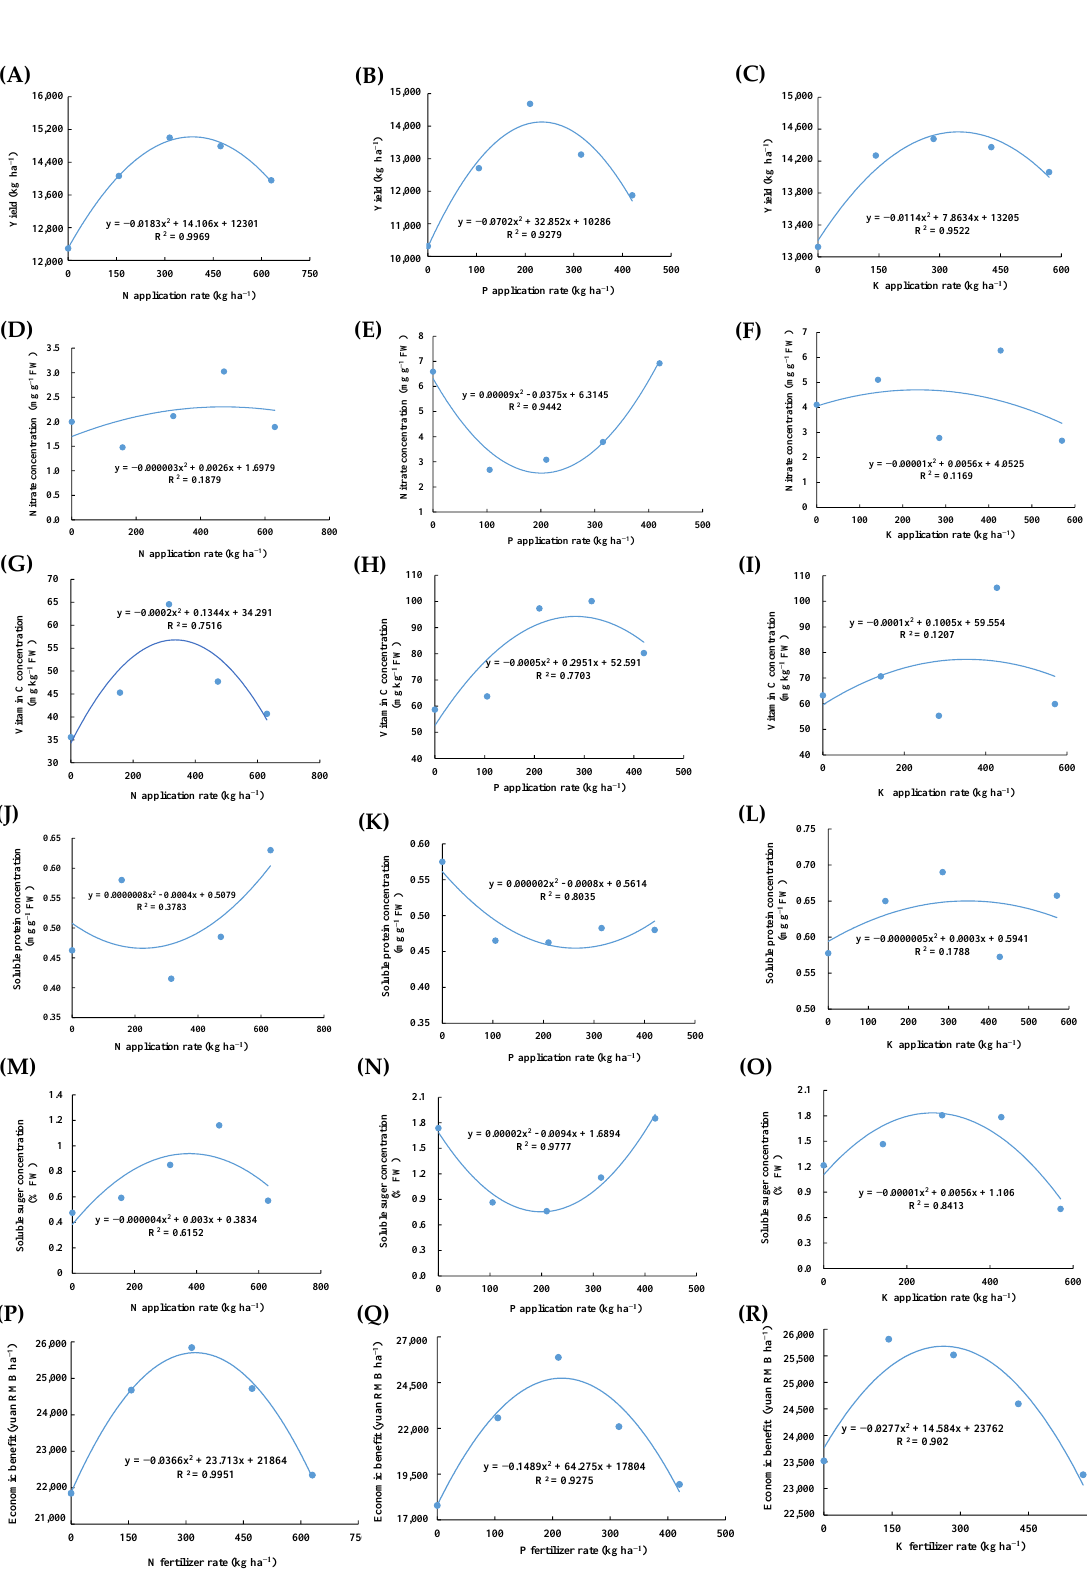
Figure 3. The models for fertilizer response of different lettuce traits under the varied nutrient application amounts. ( A – C ), yield; ( D – F ), nitrate concentration; ( G – I ), vitamin C concentration; ( J – L ), soluble protein concentration; ( M – O ), soluble sugar concentration; and ( P – R ), Economic benefit. FW, fresh